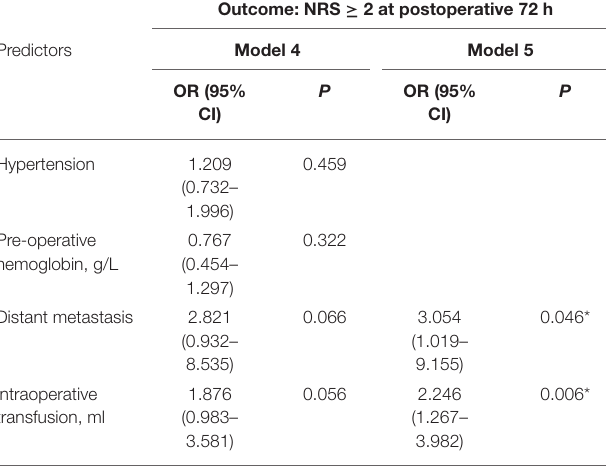
TABLE 3 | Binary logistic regression analysis for outcome postoperative NRS at 24, 48,